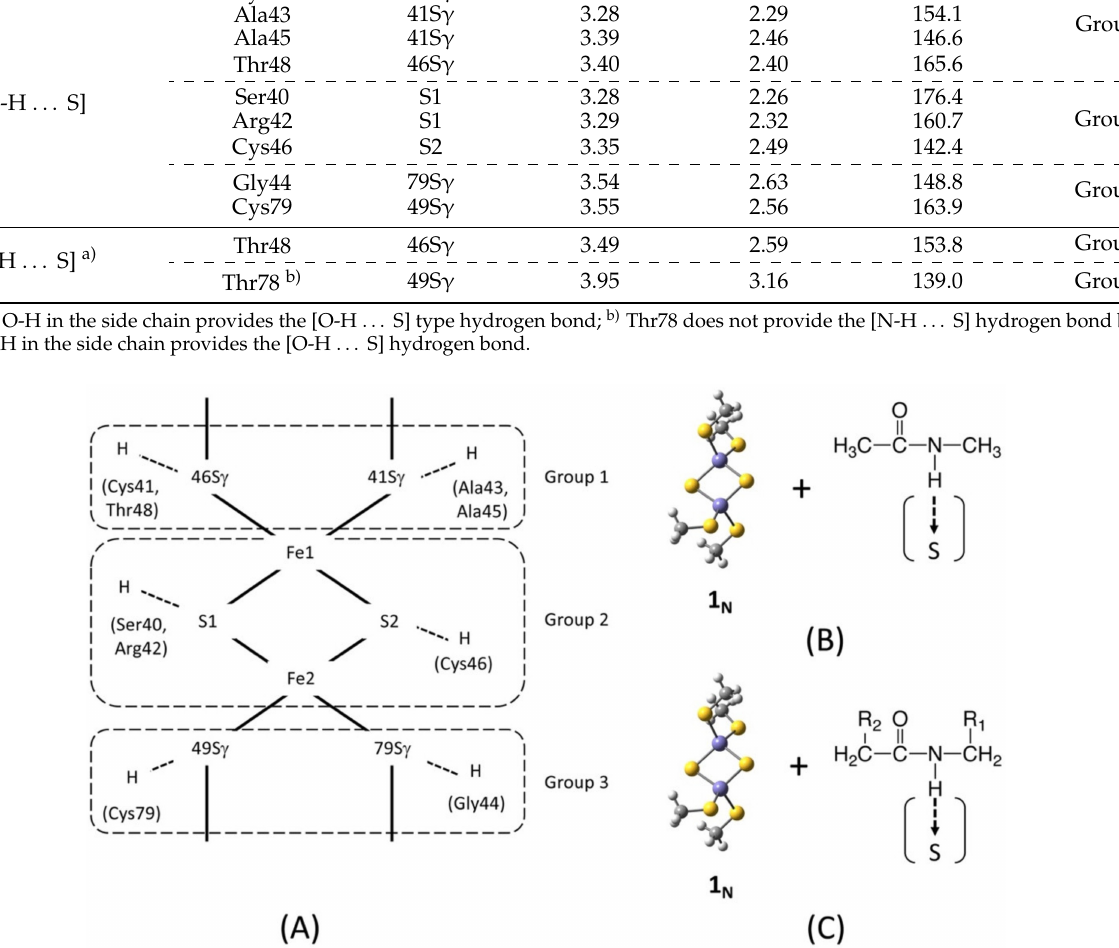
Figure 2. ( A ) Illustration of three groups of hydrogen bonds classified by the attached sulfurs. ( B ) The peptide model that consists of 1 N and peptide moiety without the side chains. ( C ) The amino acid model that consists of 1 N and peptide moiety with the side chains (R 1 and R 2 ). For both peptide and amino acid models, the proton donor is defined as the amino acid residue providing N-H